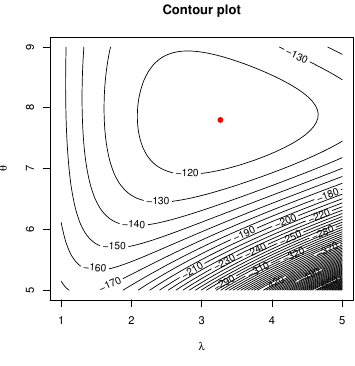
Figure 6 – Contour plot for the real data set 2.